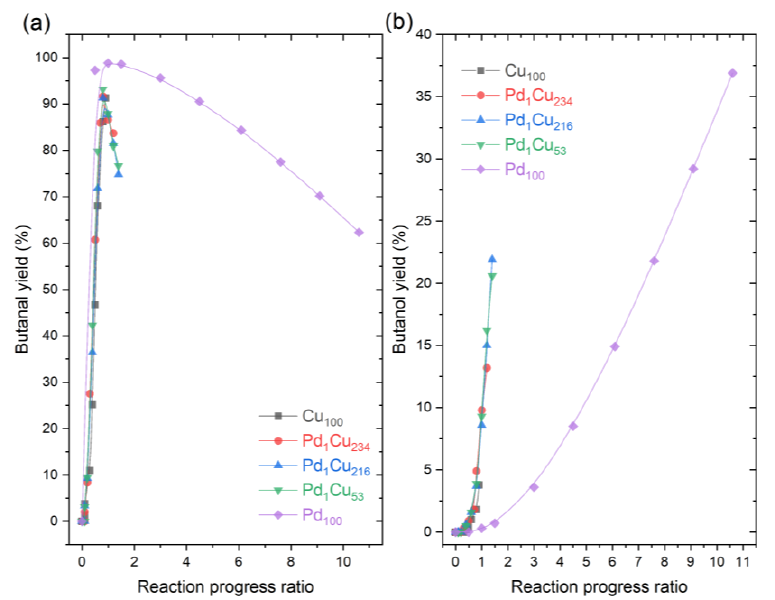
Figure 3. Yields vs. Reaction progress ratio for the hydrogenation of crotonaldehyde. ( a ) Yield of butanal; ( b ) Yield of butanol. Reaction conditions: 7 h, 50 °C, 1.5 bar H 2 , 600 RPM, and 10 mg of catalyst.